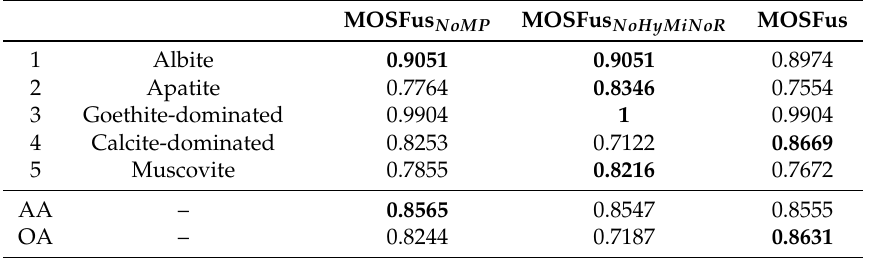
Table 7. The effects of HyMiNoR and MP on the classification accuracies for the RZ2 dataset. The highest accuracy in each row is shown in